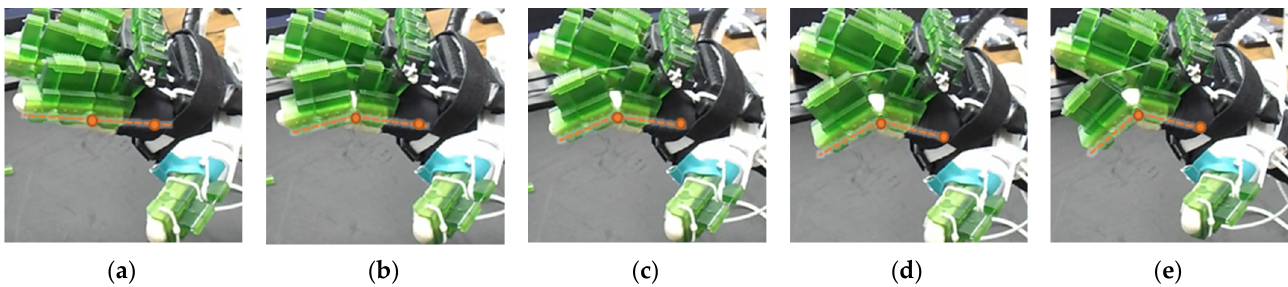
Figure 16. Isolated PIP flexion of index finger: ( a ) hand is at extended position, PIP joint angle: 0°; ( b – d ) intermediate PIP joint positions; and ( e ) PIP joint angle: 70°.